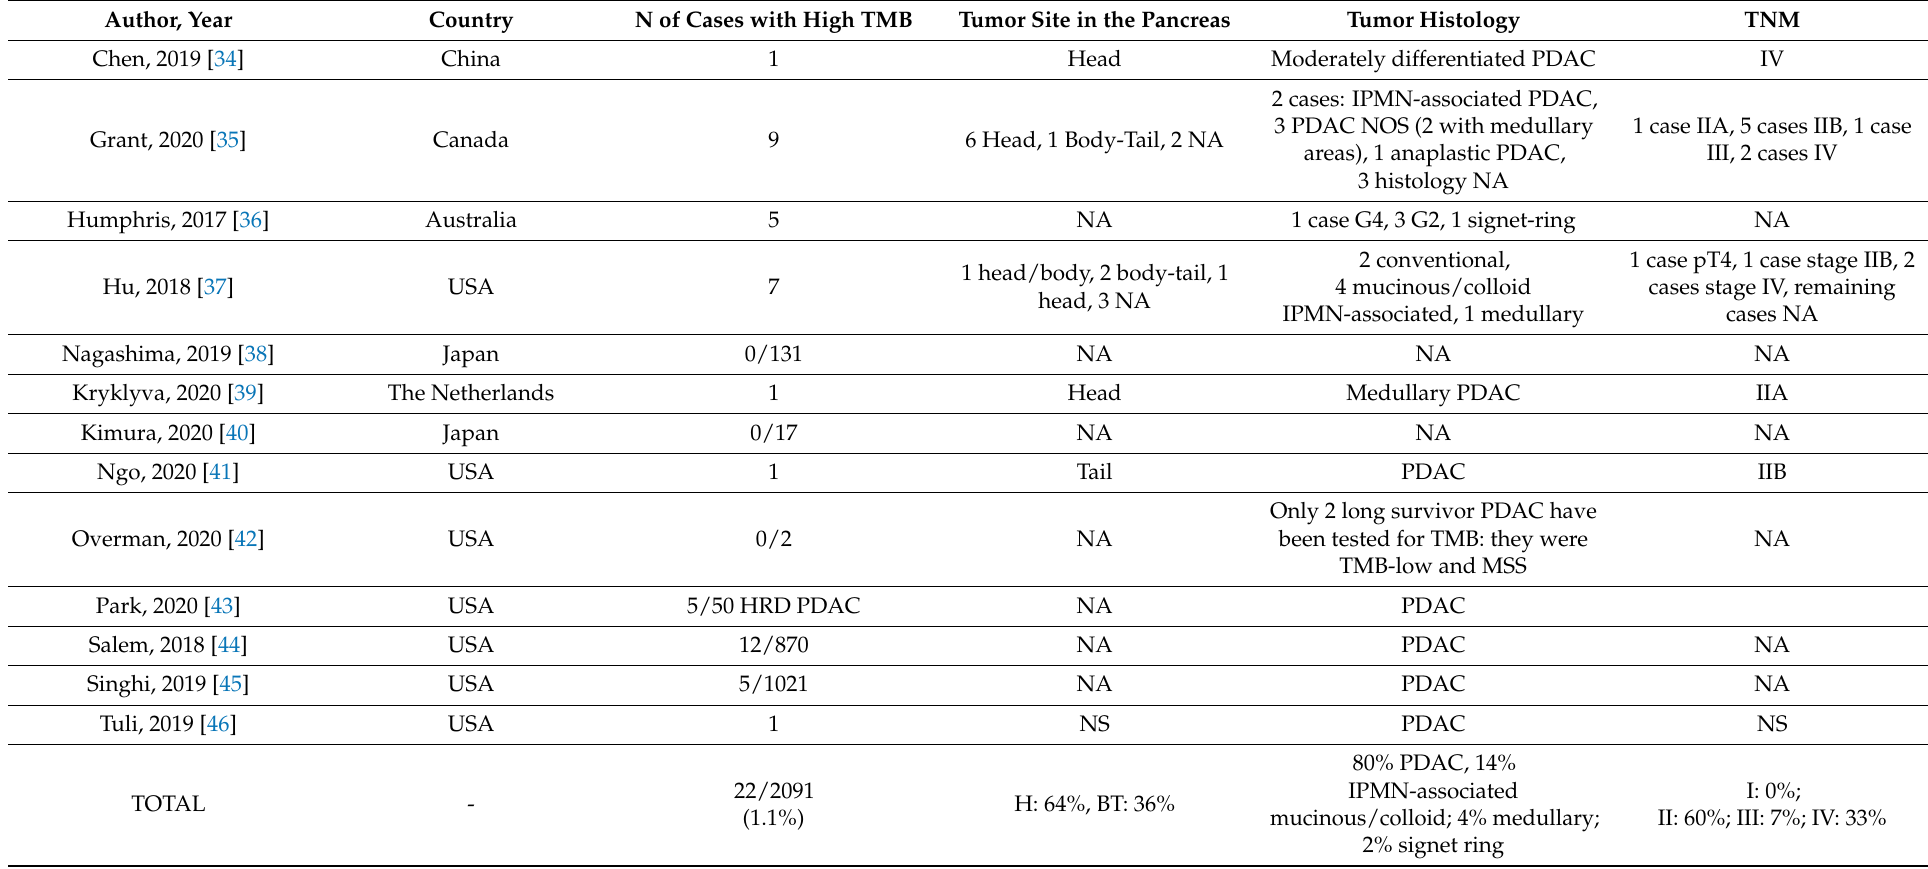
Table 1. Summarizing table of the main clinic-pathologic features of all PDAC tested for tumor mutational